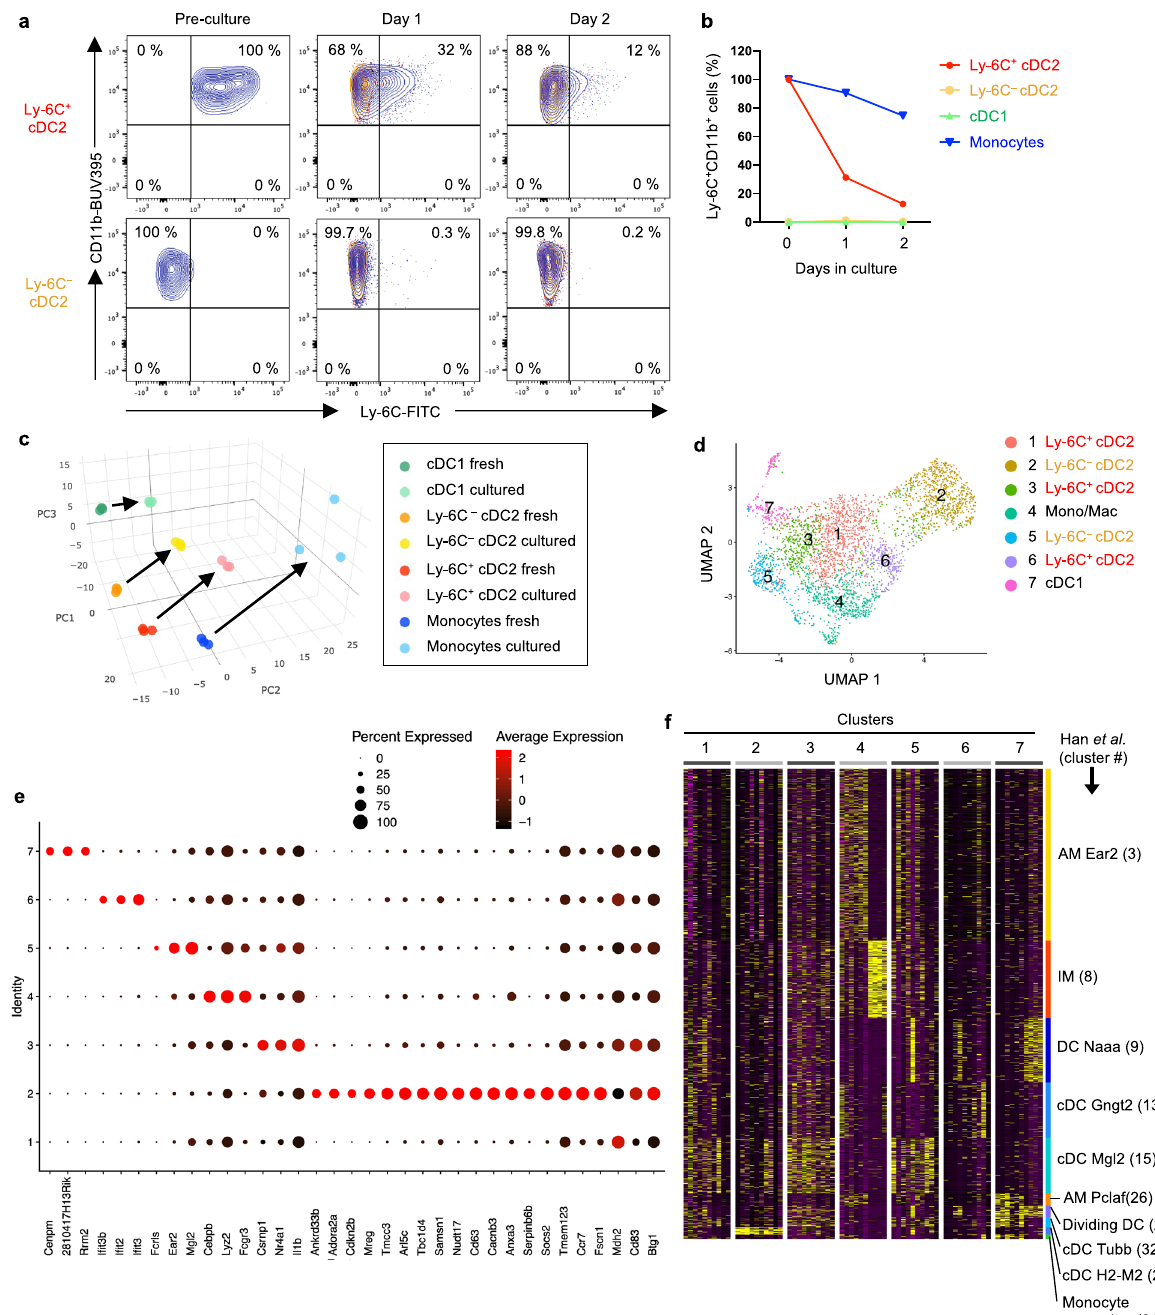
Fig. 5 Developmental fate of Ly-6C + cDC2. a , b Surface Ly-6C on freshly isolated cDC2, and after their ex vivo culture. Representative cytograms for Ly- 6C + and Ly-6C – cDC2 ( a ), and compiled data for Ly-6C + cDC2, Ly-6C – cDC2, cDC1 and monocytes ( b ) are shown. The gating strategy for cell sorting is shown in Supplementary Fig. 9a. Blue and orange contour plots show cells stained with anti-Ly-6C Abs and rat IgM isotype control, respectively. c PCA plots for gene expression (NanoString) in freshly isolated or cultured cDCs and monocytes. d UMAP plots showing cDC2 clusters identi fi ed by Seurat analysis of scRNA-Seq data. The key denotes identity of clusters, including fi ve cDC2 clusters (three Ly-6C + and two Ly-6C – ). The gating strategy for cDC2 sorting is shown in Supplementary Fig. 3a. e Representative DEGs for the seven identi fi ed clusters. f Heatmap comparing expression of 10 diagnostic DEGs for each of the seven clusters shown in ( d ), with clusters identi fi ed by Han et al. 24 . Source data are provided as a Source Data fi